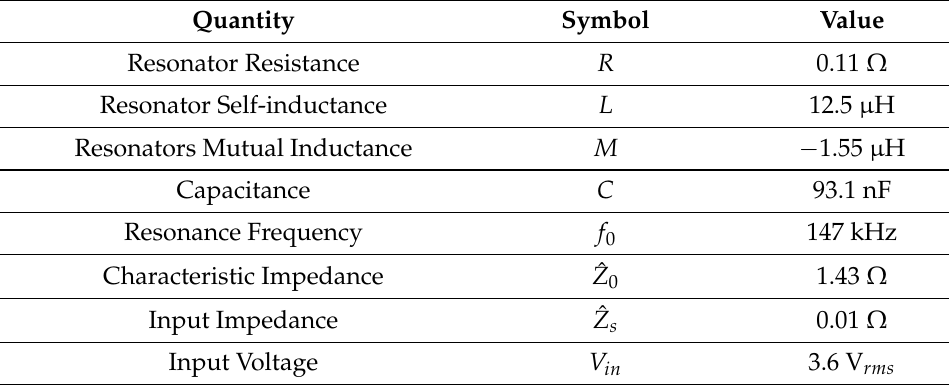
Table 1. Resonator array